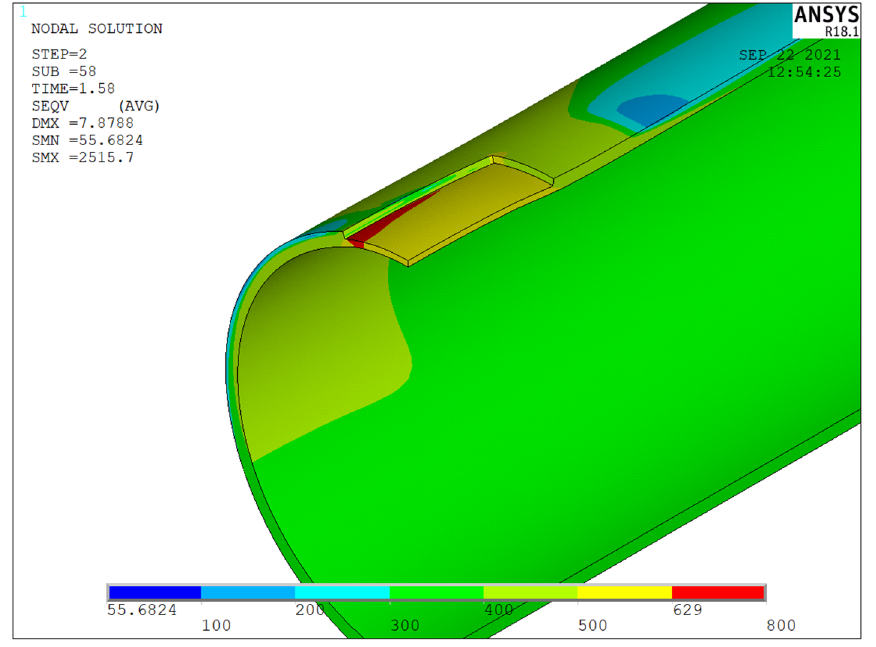
Figure 6. Von Mises stress distribution of a failed corroded pipe with single defect.